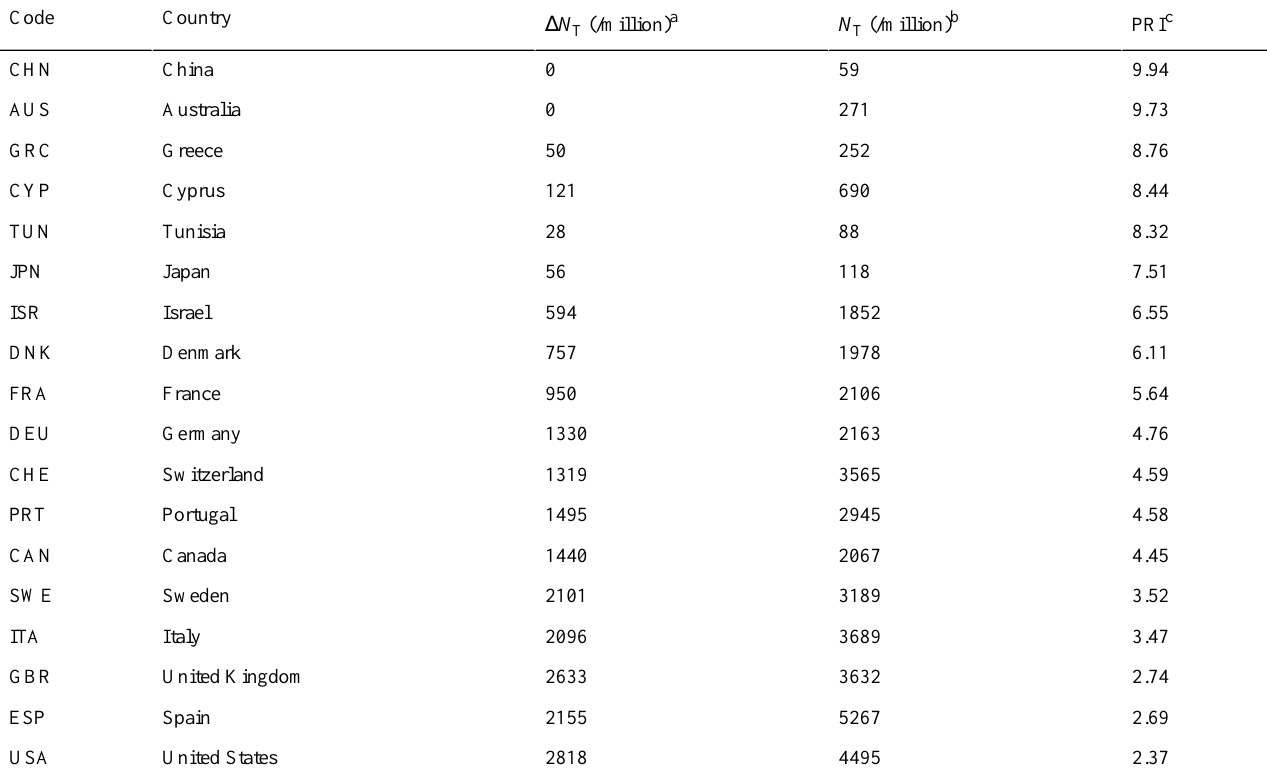
Table 2. Ranking of the various countries according to the PRI, defined in equation